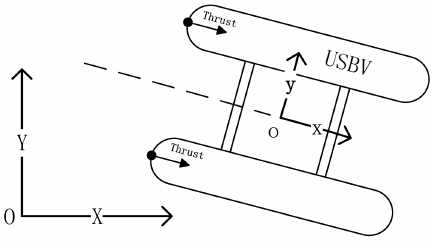
Figure 1. Earth-fixed coordinate axes O-XY and body-fixed coordinate axes